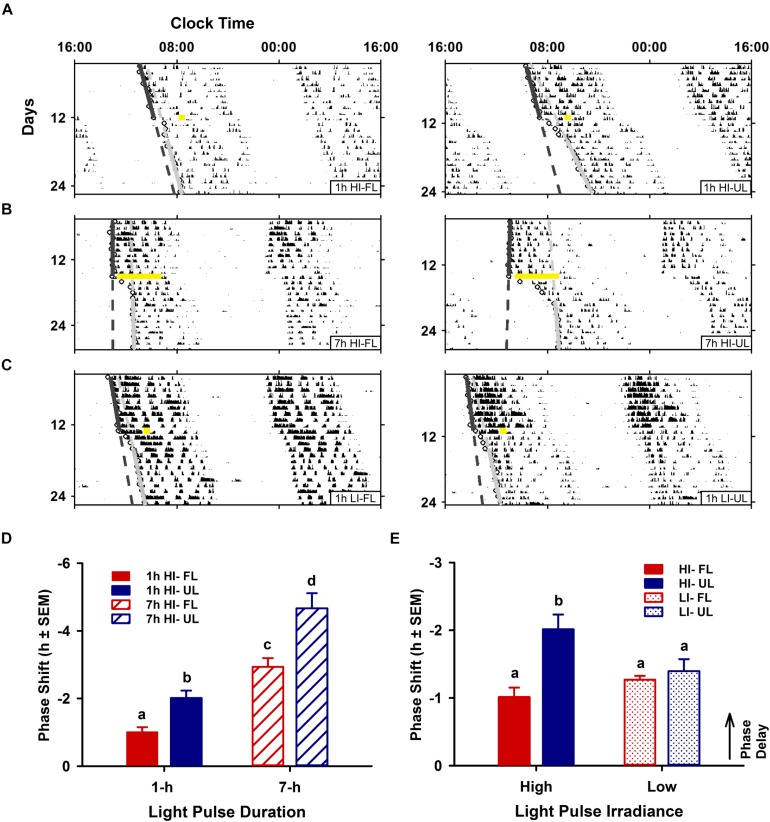
Effects of duration and irradiance on behavioral phase shifts in response to short-wavelength-filtered light (FL) or unfiltered light (UL) exposure. Representative double-plotted actograms of wheel-running activity from free-running animals exposed to a 1-h high irradiance (HI ∼100 μW/cm2; A) or low irradiance (LI ∼10 μW/cm2; C) light pulse of completely filtered (< 500 nm, FL; left) or unfiltered light (UL; right) at CT16, and free-running animals exposed to a 7-h HI light pulse (B) of FL (left) or UL (right) at CT 13. Phase shifts were assessed by generating regression lines through the activity onsets for at least 10 days before and after photic intervention (indicated by a yellow bar). Completely filtering short wavelengths reduced phase delays for both shorter 1-h and longer 7-h HI light exposures (D), as compared to unfiltered light (1-h HI: FL n = 10, UL n = 11; 7-h HI: FL n = 9, UL n = 9). Conversely, filtering visual short wavelengths under a 1-h low irradiance light exposure did not alter phase shifts (E), as compared to unfiltered light (1-h LI: FL n = 9, UL n = 9). Quantitation of photic phase shifts are reported as group mean ± SEM. Different letters indicate significant differences (p < 0.05) after a two-way (exposure condition × irradiance or exposure condition × duration, as indicated) ANOVA with Student-Newman-Keuls post hoc test.